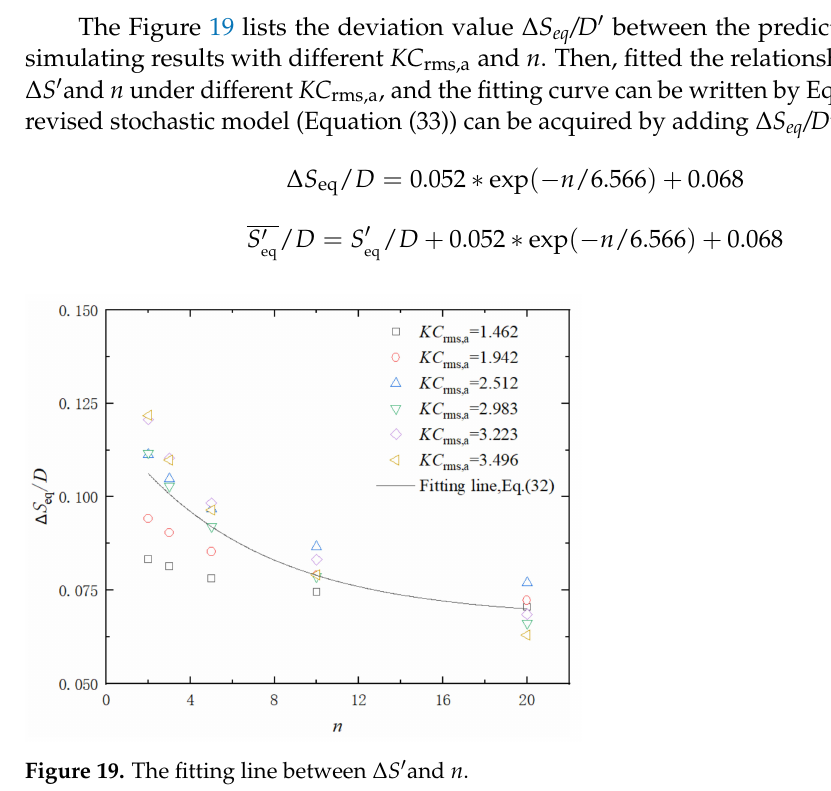
Figure 18. Comparison of S eq between the simulating results and the predicting values by Equation (8).